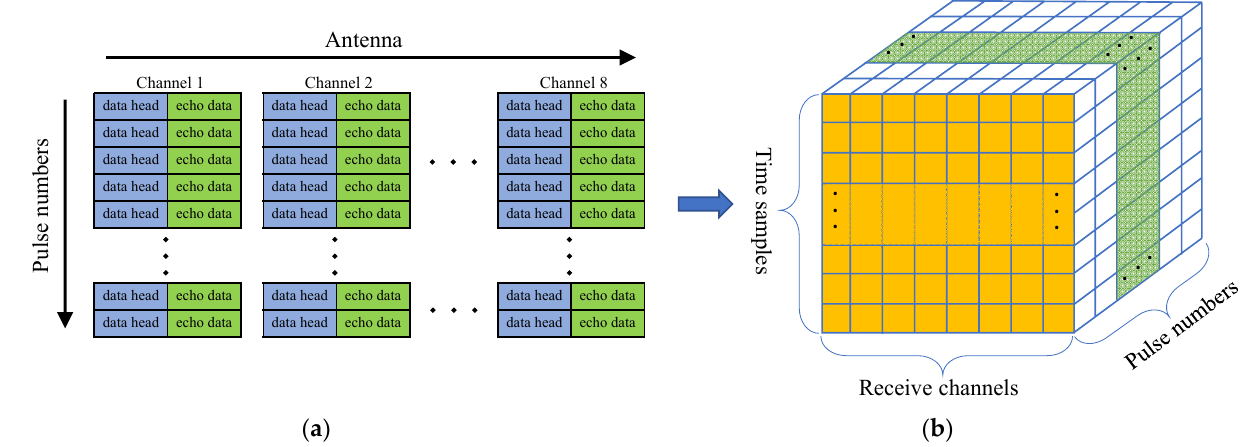
Figure 3. Radar data structure. ( a ) The storage format of echo data; ( b ) Radar data cube within a CPI.